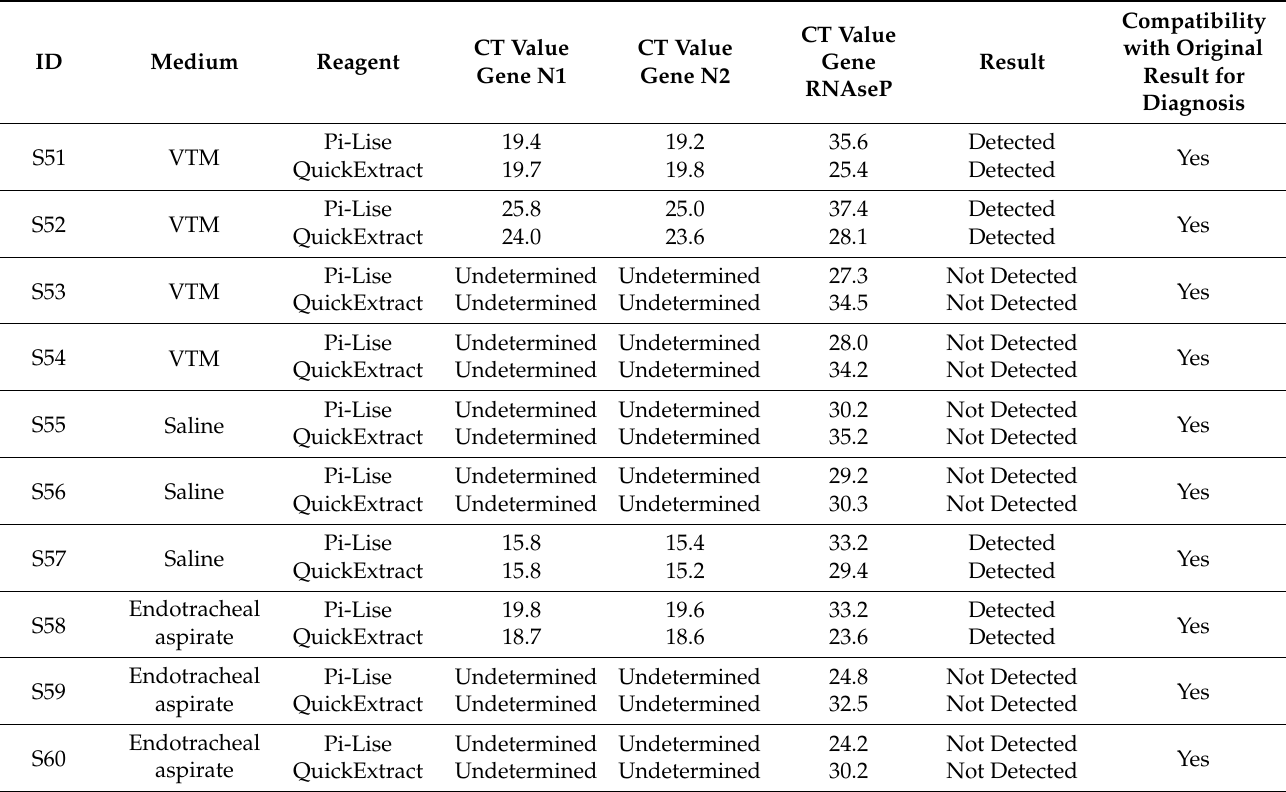
Table 2. RT-qPCR results of reactions performed with Bio-rad kit and IDT primers-probes after extraction with different reagents (Pi-Lise or QuickExtract).